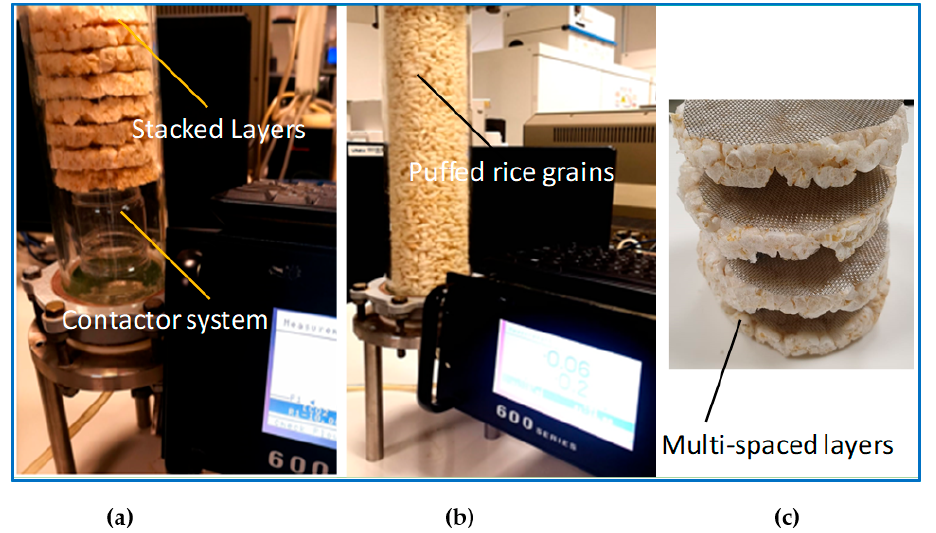
Figure 6. Picture of the contactor system loaded with the operation options, ( a ) staked rice cake layers ( b ) puffed rice grains, and ( c ) multi-spaced layers in operation conditions, at a gas flow rate of (300 mL/min).